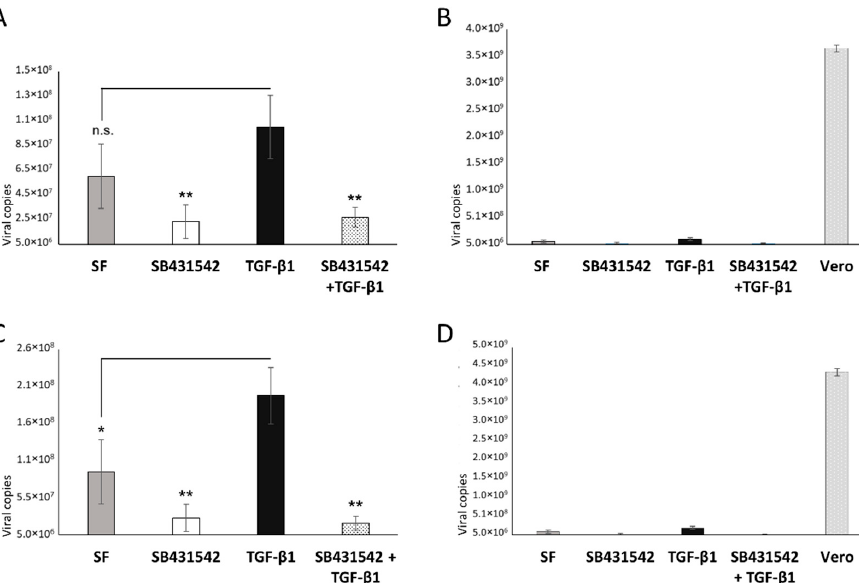
Figure 4. Quantifying viral progeny production in the supernatants collected at 48 hpi by real- time PCR. ( A , B ) Pre-infection treatments of TGF- β 1 and/or its inhibitor SB431542. Swan.71 cells were cultured and pre-treated with TGF- β 1 and the inhibitor before ZIKV infection. ( C , D ) Post- infection treatments of TGF- β 1 and/or its inhibitor SB431542. The Swan.71 cells were infected with ZIKV without any pretreatments. TGF- β 1 and/or the inhibitor were added to the culture at 4 hpi. Supernatant collected from ZIKV-infected Vero cells was used as the positive control. The results are expressed as the mean of at least triplicate experiments in each group, and each graph is representative of three independent experiments. n.s., not significant; *, p < 0.05; **, p < 0.01. ( B , D ) Data obtained from Vero cells were included in the graphs for comparative